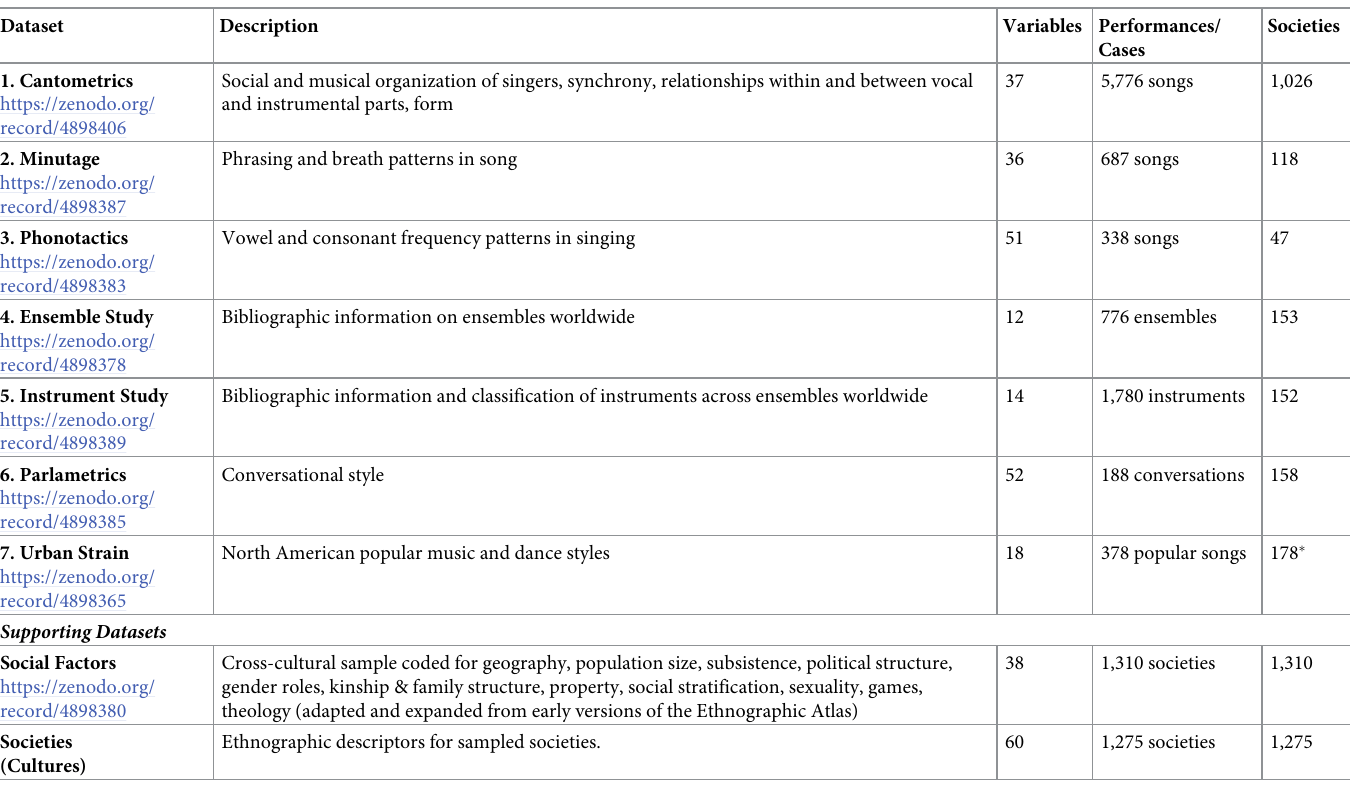
Table 1. Global Jukebox datasets included in this public